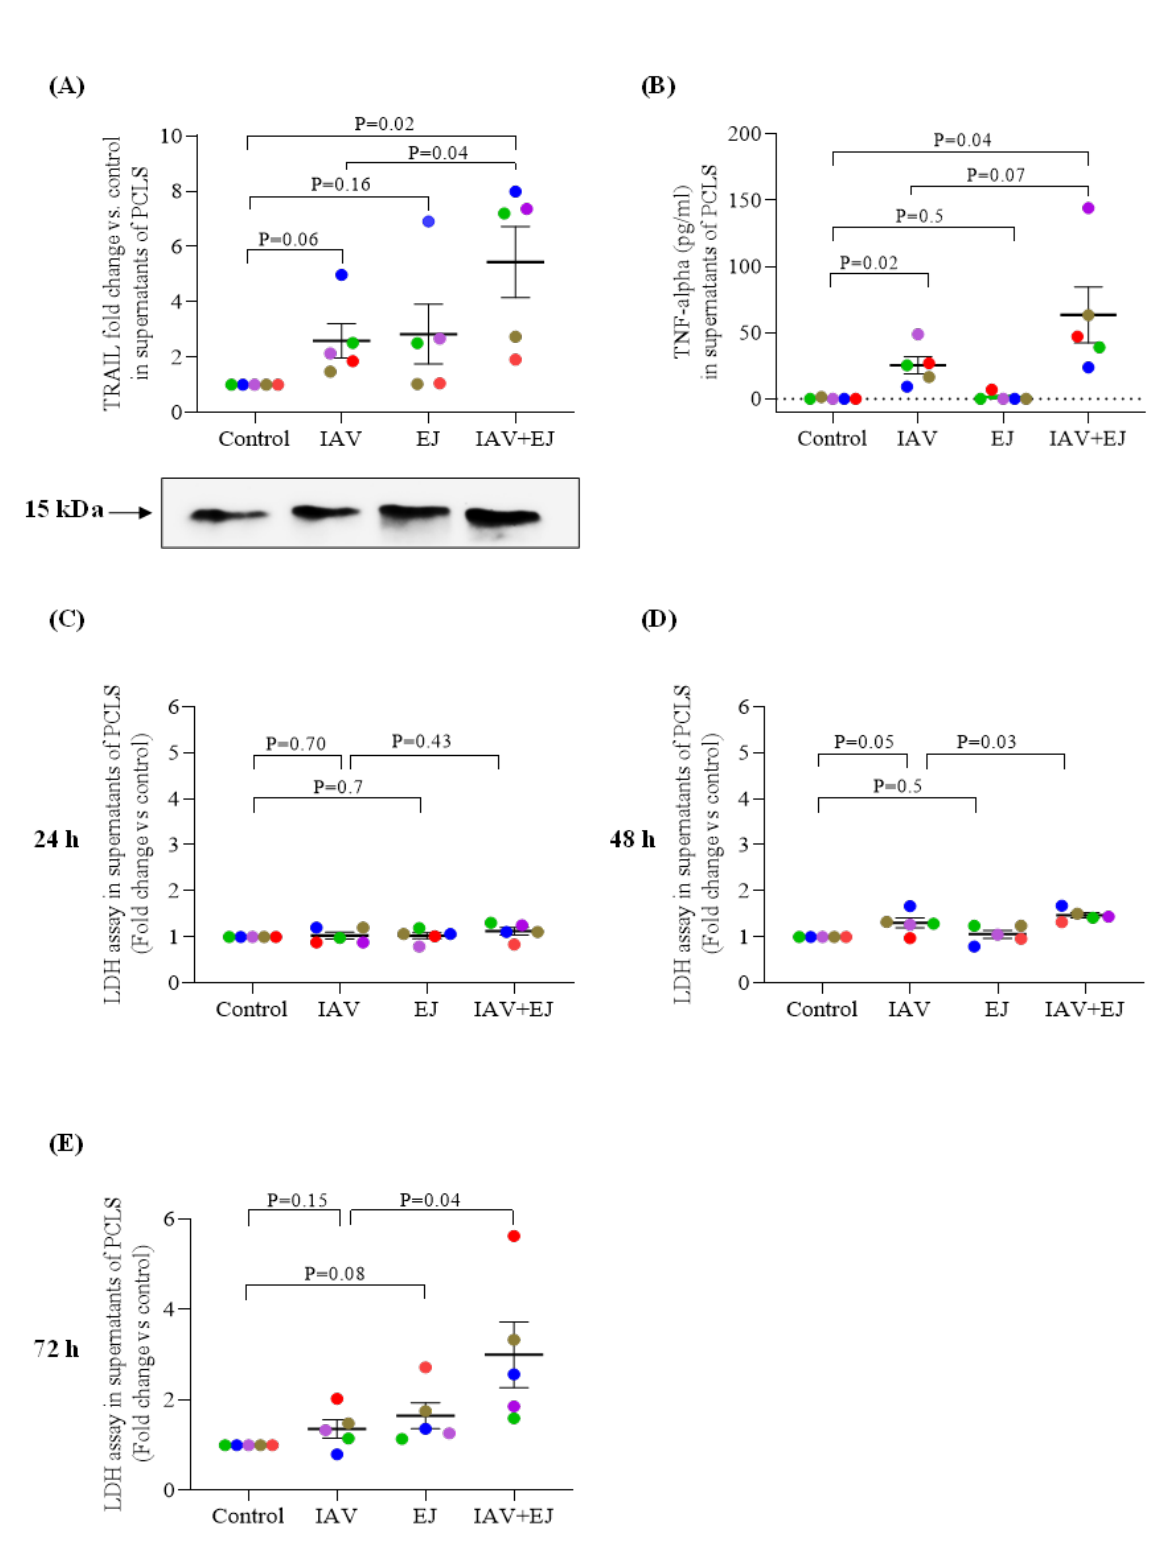
Figure 2. E-juice treatment increased TRAIL, TNF- α release and cytotoxicity in human precision-cut lung slices (PCLS) infected with influenza A virus (IAV). PCLS were treated with IAV and E-juice (EJ) for 24, 48, and 72 h. ( A ) TRAIL release (72 h) in supernatants analyzed by western blotting. ( B ) TNF- α release (72 h) in supernatants analyzed by ELISA. ( C – E ) Cytotoxicity was analyzed by performing the LDH assay. Each data point (colored dot) represents the average of 3 replicates from each respective individual donor ( n = 5 donors). Horizontal lines indicate mean ± SEM. Paired t -test was used to analyze the